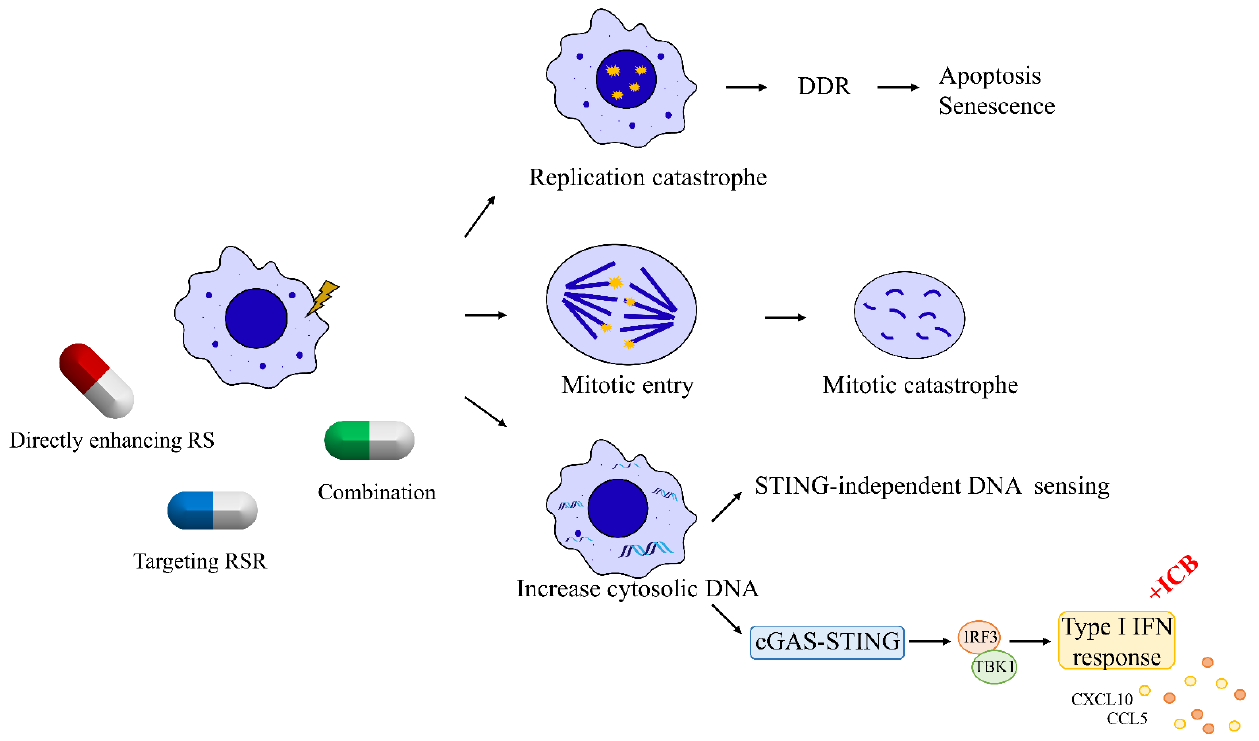
Figure 2. Targeting DNA replication stress in breast cancer. Breast cancer cells harboring RS can be targeted through three major mechanisms. First, RS can be harnessed in breast cancer cells with high intrinsic RS to induce replication catastrophe. Second, breast cancer cells can be targeted by abro- gating their G2 – M cell-cycle checkpoint to induce mitotic catastrophe. Third, breast cancer cells with high intrinsic RS exhibit high levels of cytosolic DNA leaking from nucleus, which can trigger inter- feron signaling to prime tumor for immune therapies.